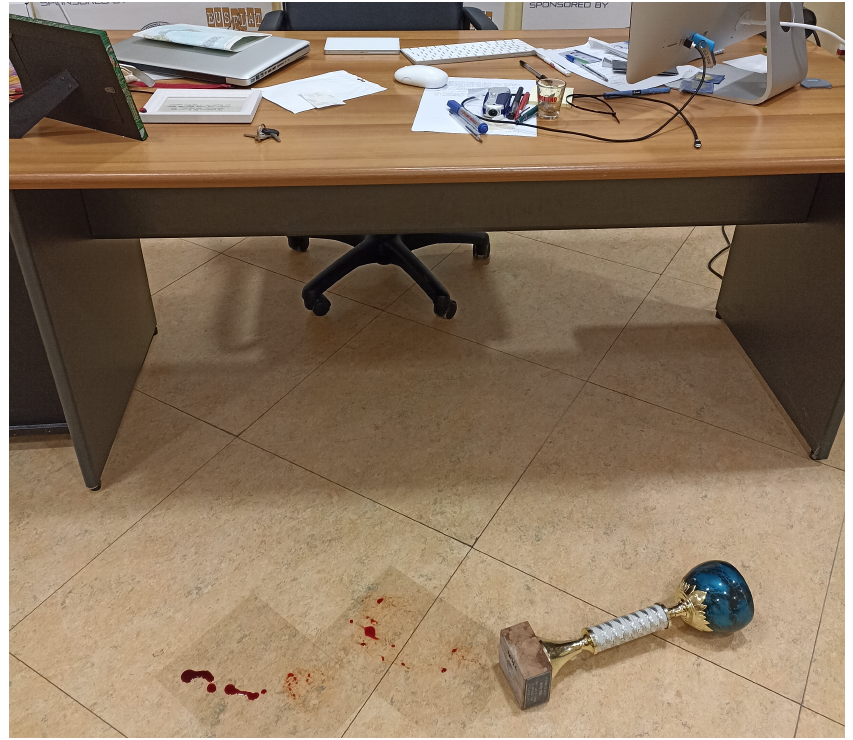
Figure 7. Crime scene that was physically reconstructed to perform the experimental